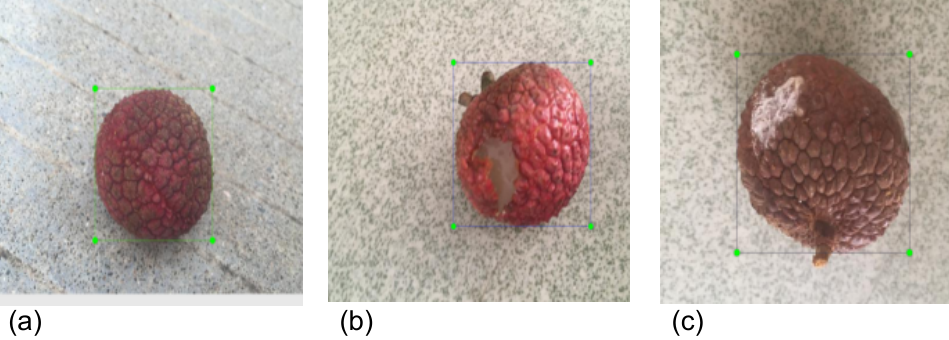
Figure 1. Lychee samples with annotated bounding boxes: ( a ) mature, ( b ) defects, and ( c )